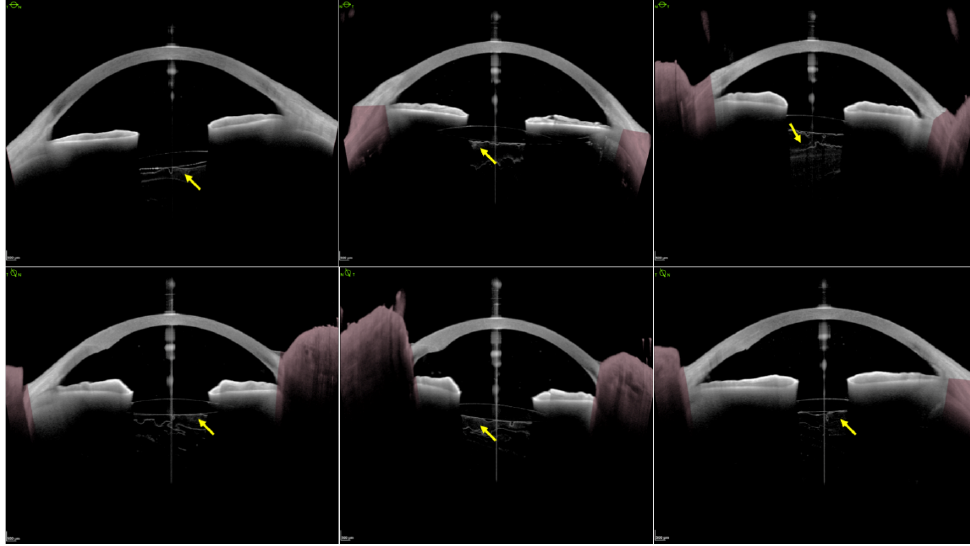
Figure 5. Scattered hyperreflective material (yellow arrows) in Berger’s space was observed in six eyes postoperatively in less than 7 days.